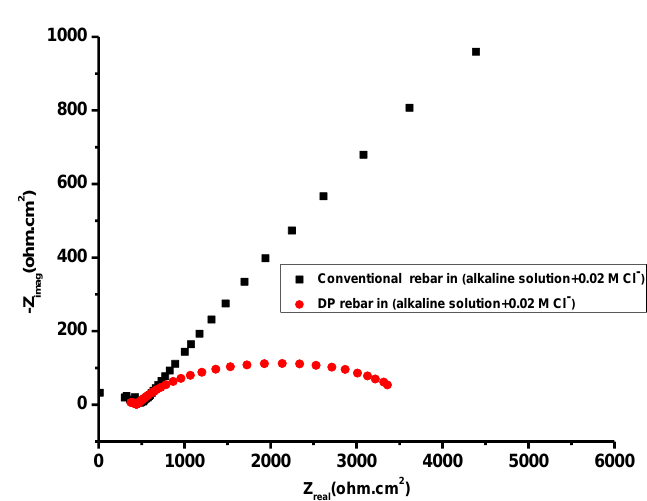
Figure 7. Electrochemical impedance spectroscopy (EIS) Nyquist curve in an alkaline solution (without Cl − ions). EIS, electrochemical impedance spectroscopy.